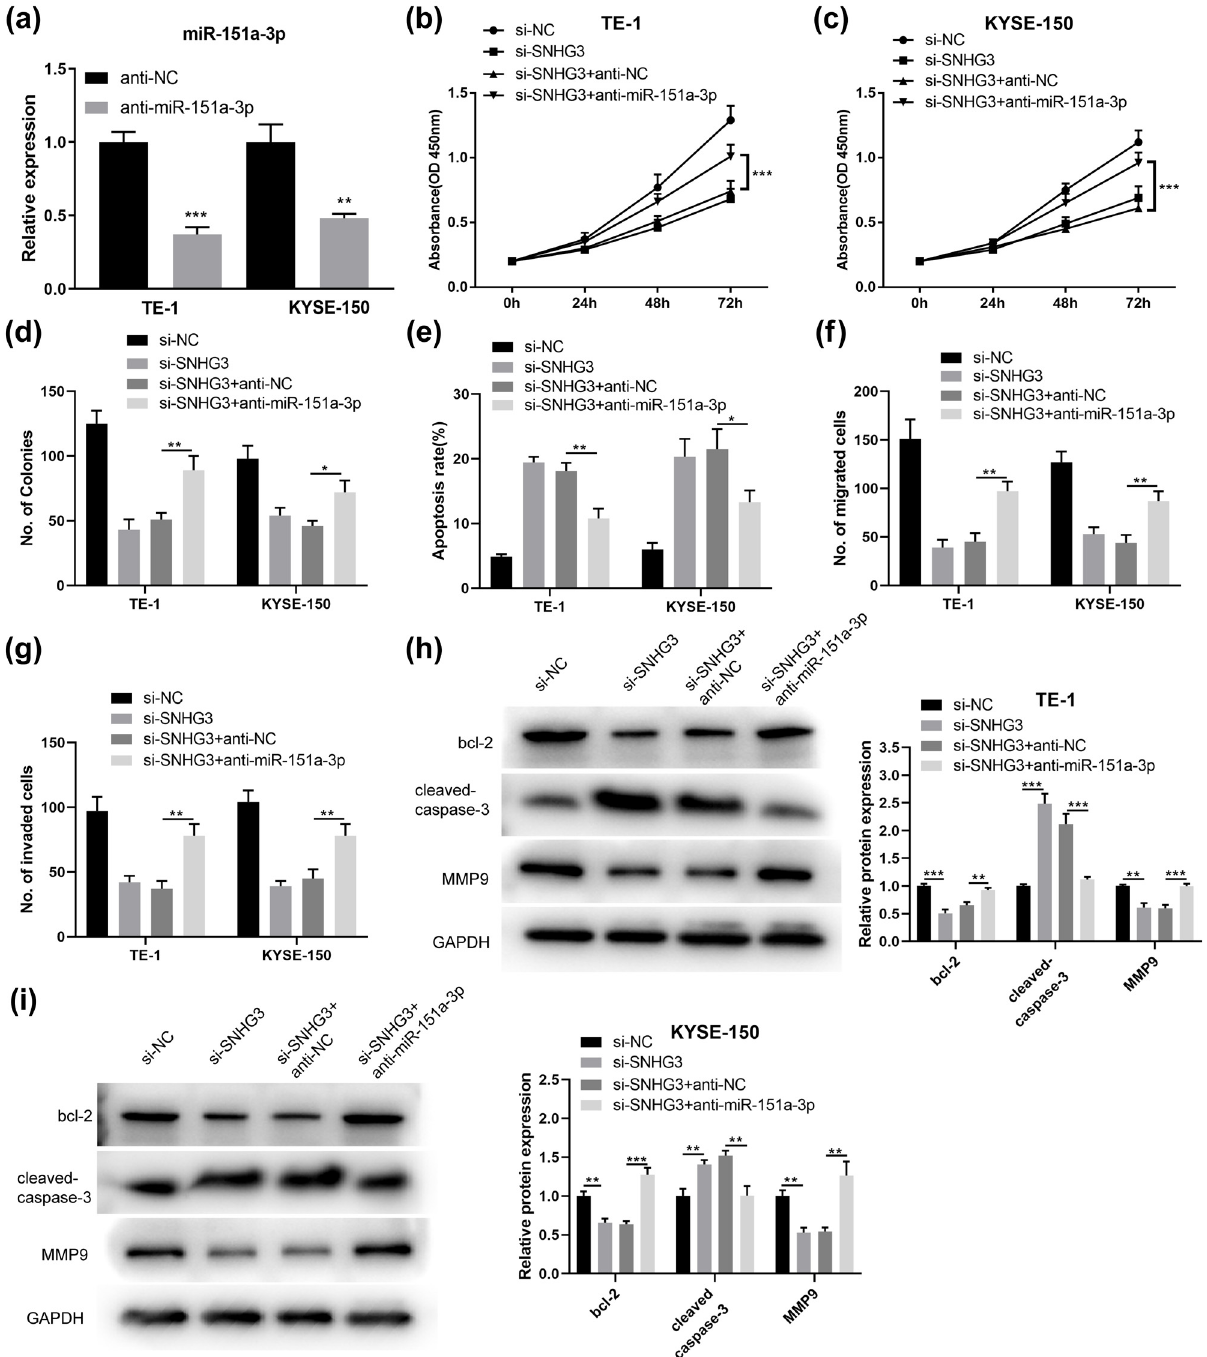
Figure 4: Inhibition of miR - 151a - 3p ameliorated the e ff ects of lncRNA SNHG3 knockdown on ESCC cell proliferation and metastasis. ( a ) The expression of miR - 151a - 3p in TE - 1 and KYSE - 150 cells transfected with anti - NC or anti - miR - 151a - 3p. CCK - 8 assay was performed for cell proliferation in TE - 1 ( b ) and KYSE - 150 cells ( c ) . ( d ) Colony formation assay was used to analyze cell colony formation ability in ESCC cells. ( e ) Flow cytometry was employed to evaluate cell apoptosis. Transwell assay was carried out for cell migration ( f ) and invasion ( g ) . Western blot assay was used to detect the protein levels of bcl - 2, cleaved - capsase - 3, and MMP9 in TE - 1 ( h ) and KYSE - 150 ( i ) cells. ( b – i ) TE - 1 and KYSE - 150 cells were transfected with si - NC, si - lncRNA SNHG3, si - SNHG3 + anti - NC, or si - SNHG3 + anti - miR - 151a - 3p. * P < 0.05, ** P < 0.01, *** P <